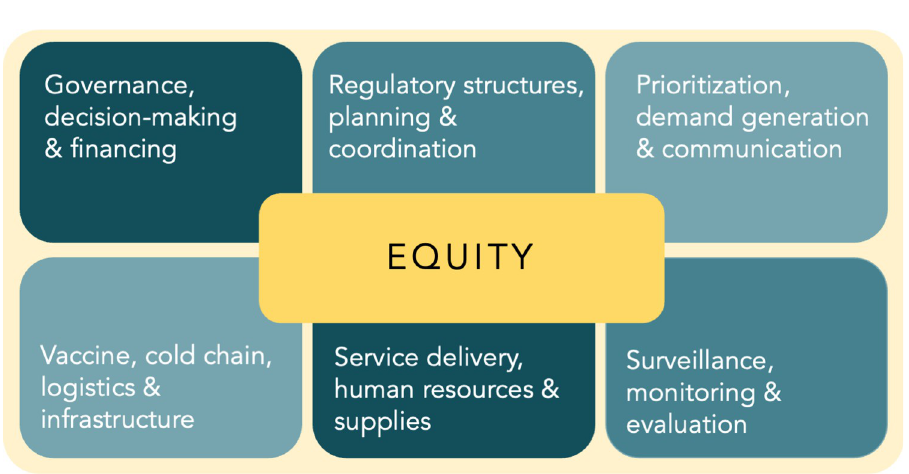
Fig 1. Modified VIRAT/VRAF